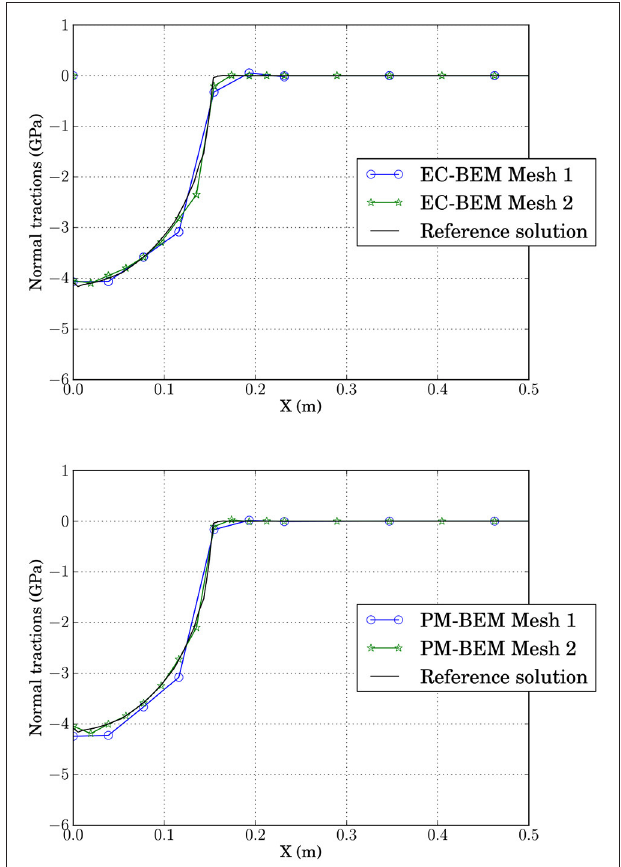
FIGURE 18 | Comparison of the normal tractions computed by EC-BEM and PM-BEM along the interface for different meshes.